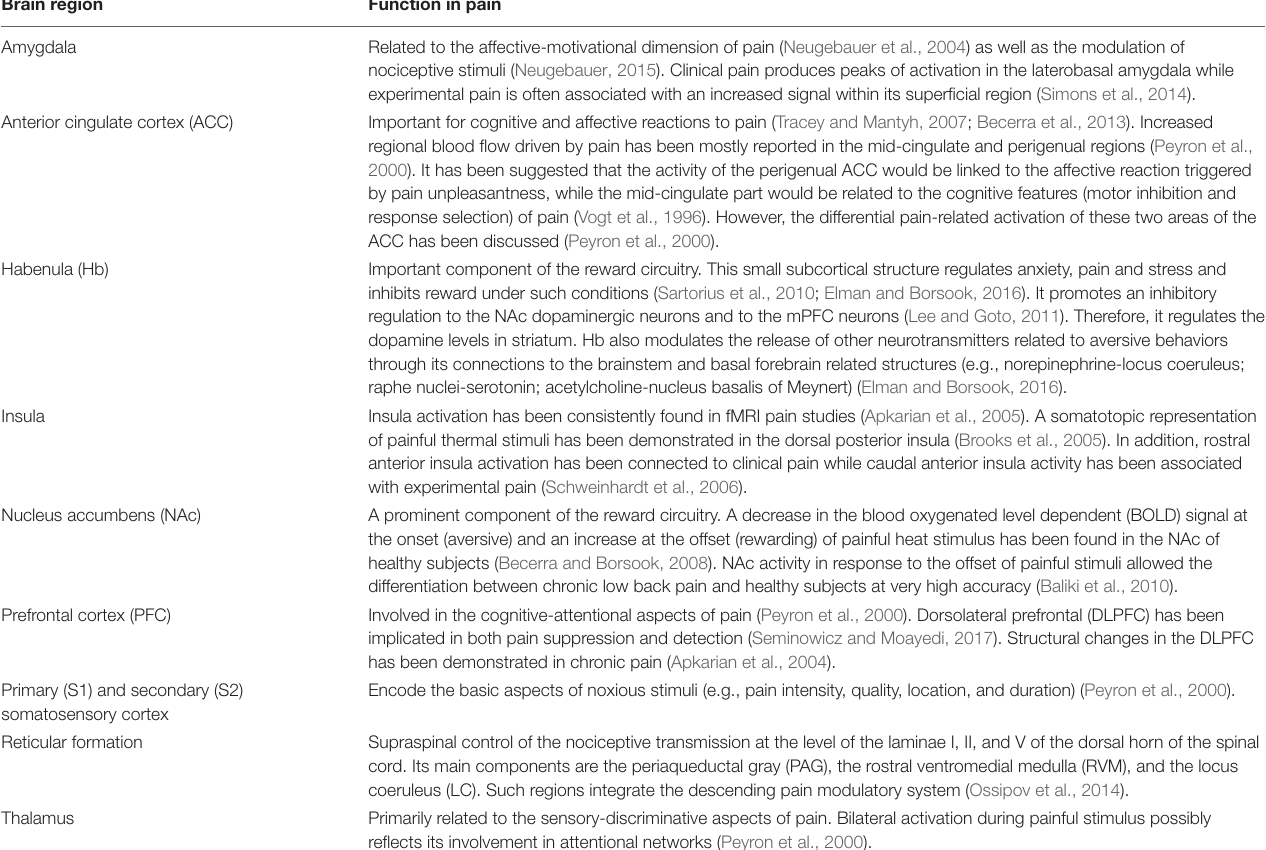
TABLE 1 | An overview of the main brain structures related to pain discussed in this article. Brain region Function in pain